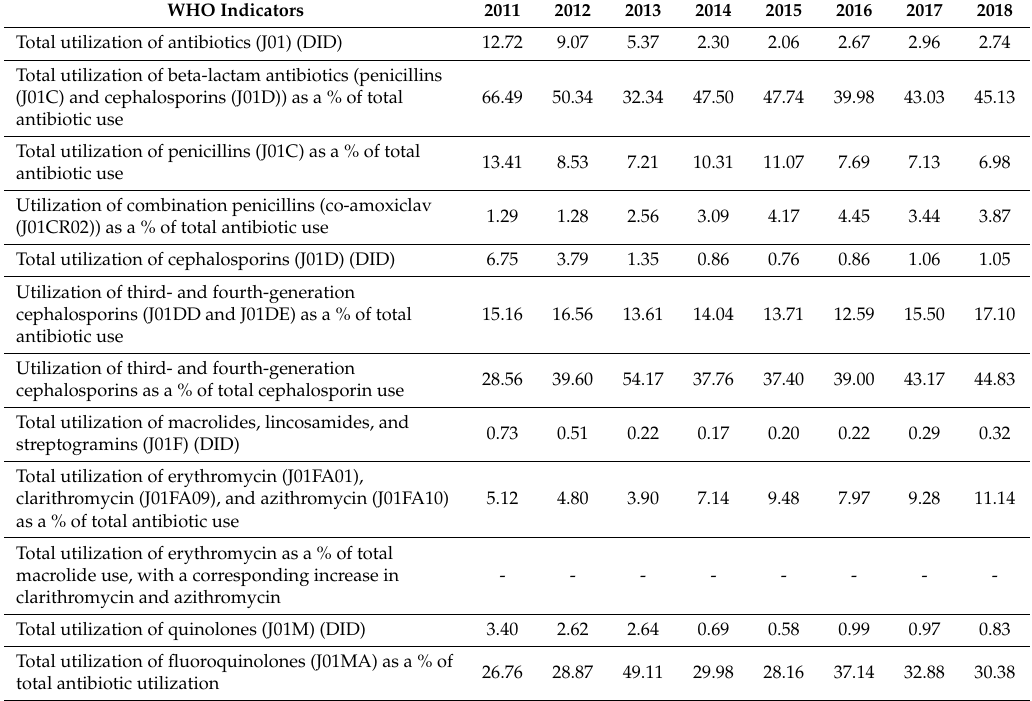
Table 3. WHO quality indicators on the use of antimicrobials. DID: defined daily dose (DDD) / 1000 inhabitants /